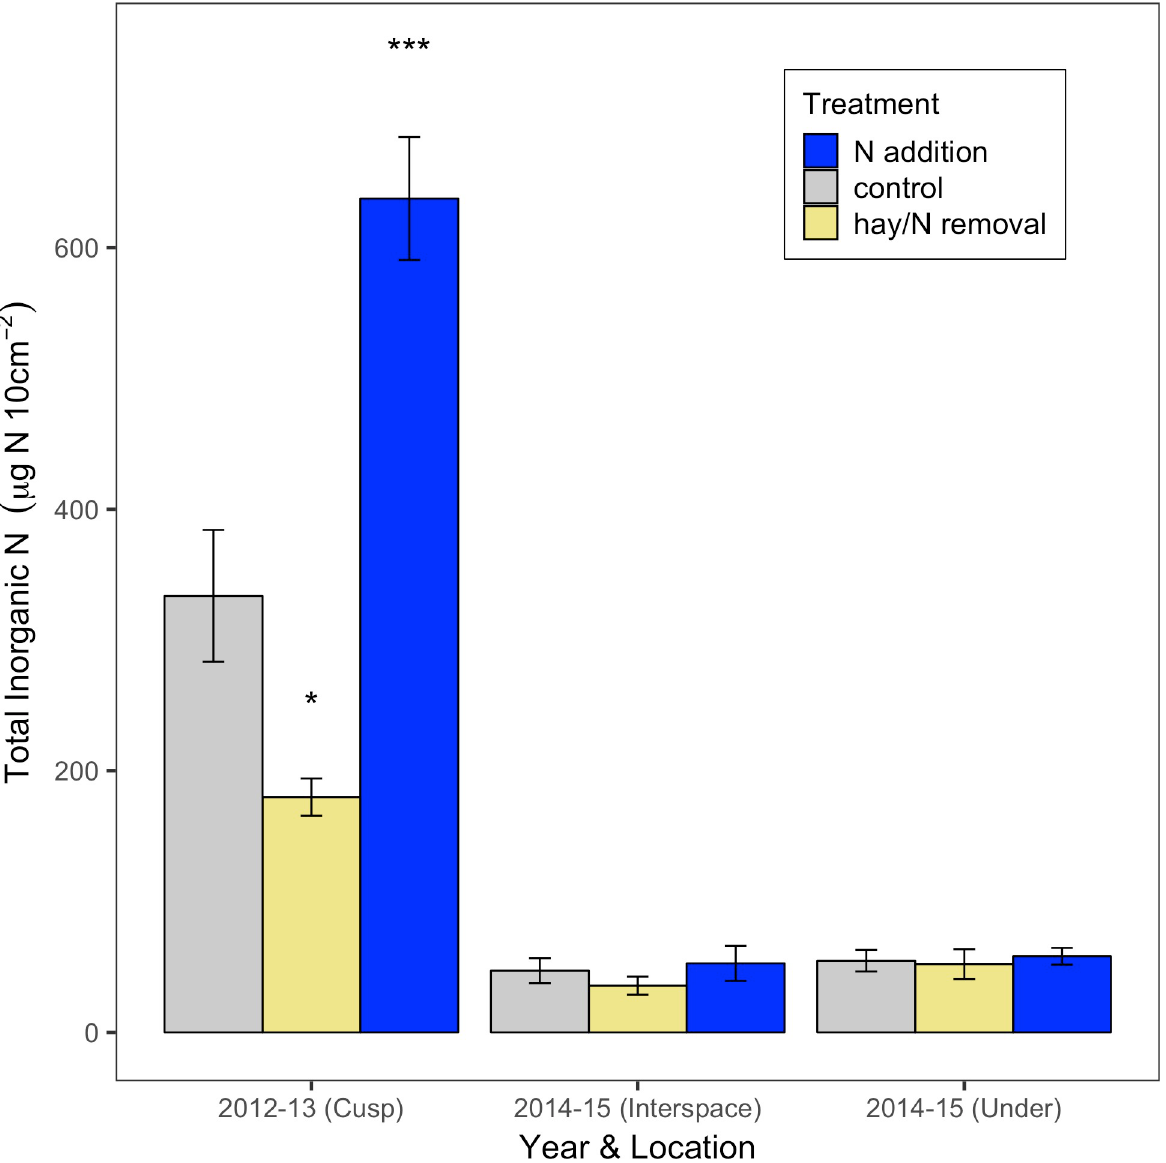
Fig 1. Mean total soil inorganic N availability within a big sagebrush plant community in Pinedale, WY. N fertilization occurred in 2012 with soil available inorganic N measured via PRS probes in fall/winter/spring of 2012–2013 and 2014–2015 (n = 5 sites). The 2013 data were collected from soil on the cusp of the canopy and interspace, while 2015 data were collected separately from within the interspace and under the canopy . Significant differences from the control, within each year and location, are indicated by asterisk based on α = 0.05 ( � indicates p < 0.05, ��� indicates p < 0.001). Whiskers indicate the standard error based on among-site